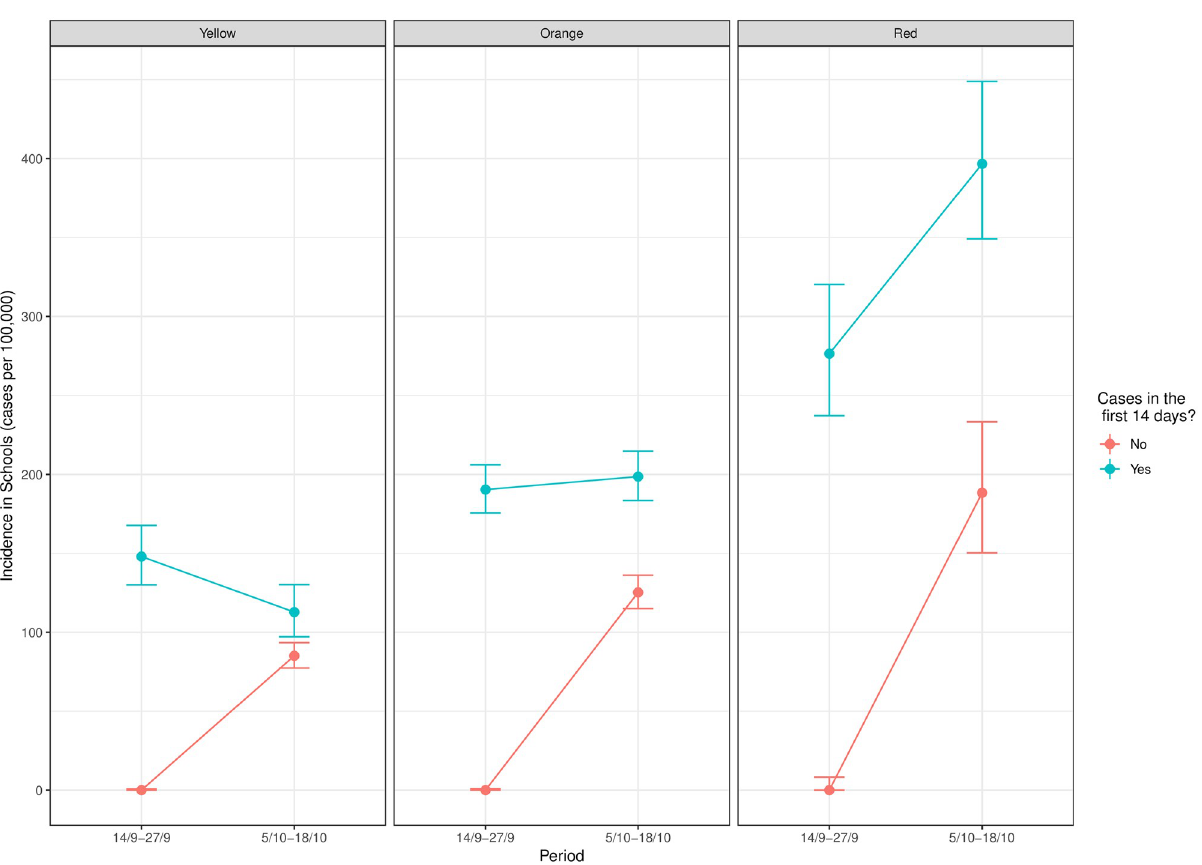
Fig 1. Weekly SARS-CoV-2 school incidence (cases per 100,000 students in 14 days) for weeks 1–2 and weeks 4–5 of the academic year in all public schools which had and did not have cases in weeks 1–2, stratified by the community incidence levels in the corresponding Basic Health Areas, as defined by the Harvard Global Health Institute [11] COVID-19 Risk Levels for reopening schools by daily incidence per 100,000 inhabitants (Yellow (1–10), Orange (10–25) and Red ( >